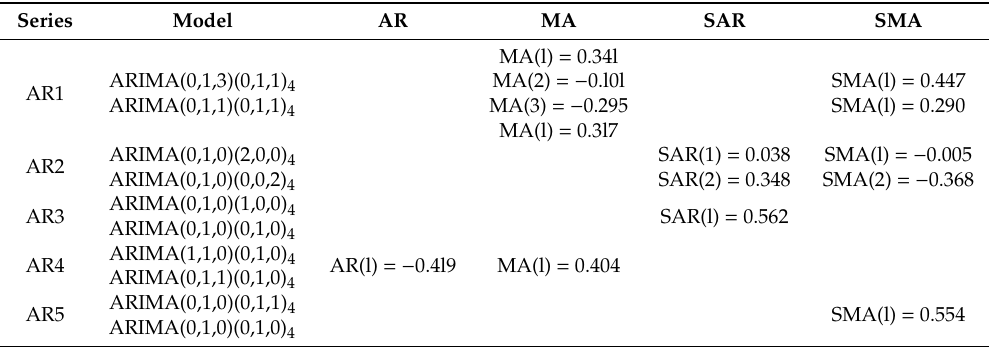
Table 4. Estimated parameter values for seasonal ARIMA models.